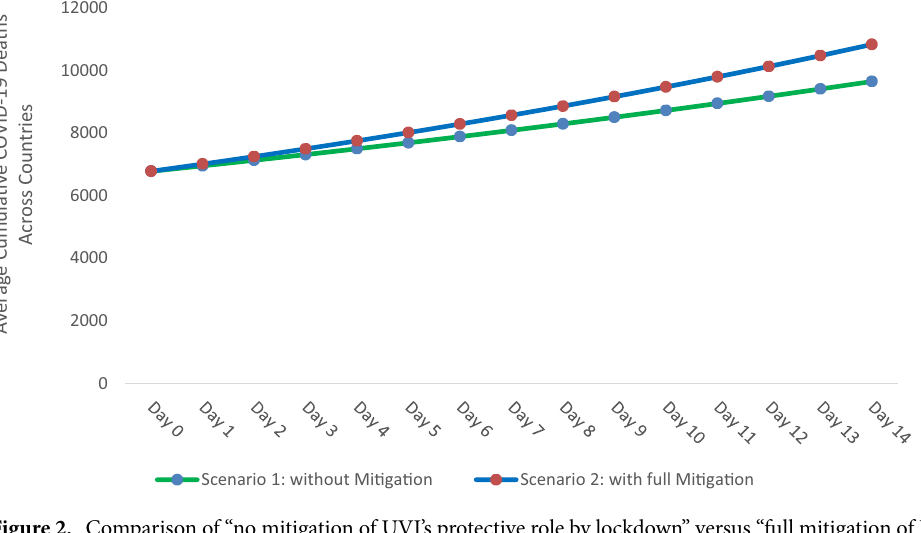
Figure 2. Comparison of “no mitigation of UVI’s protective role by lockdown” versus “full mitigation of UVI’s protective role by lockdown” on cumulative COVID-19 deaths averaged across